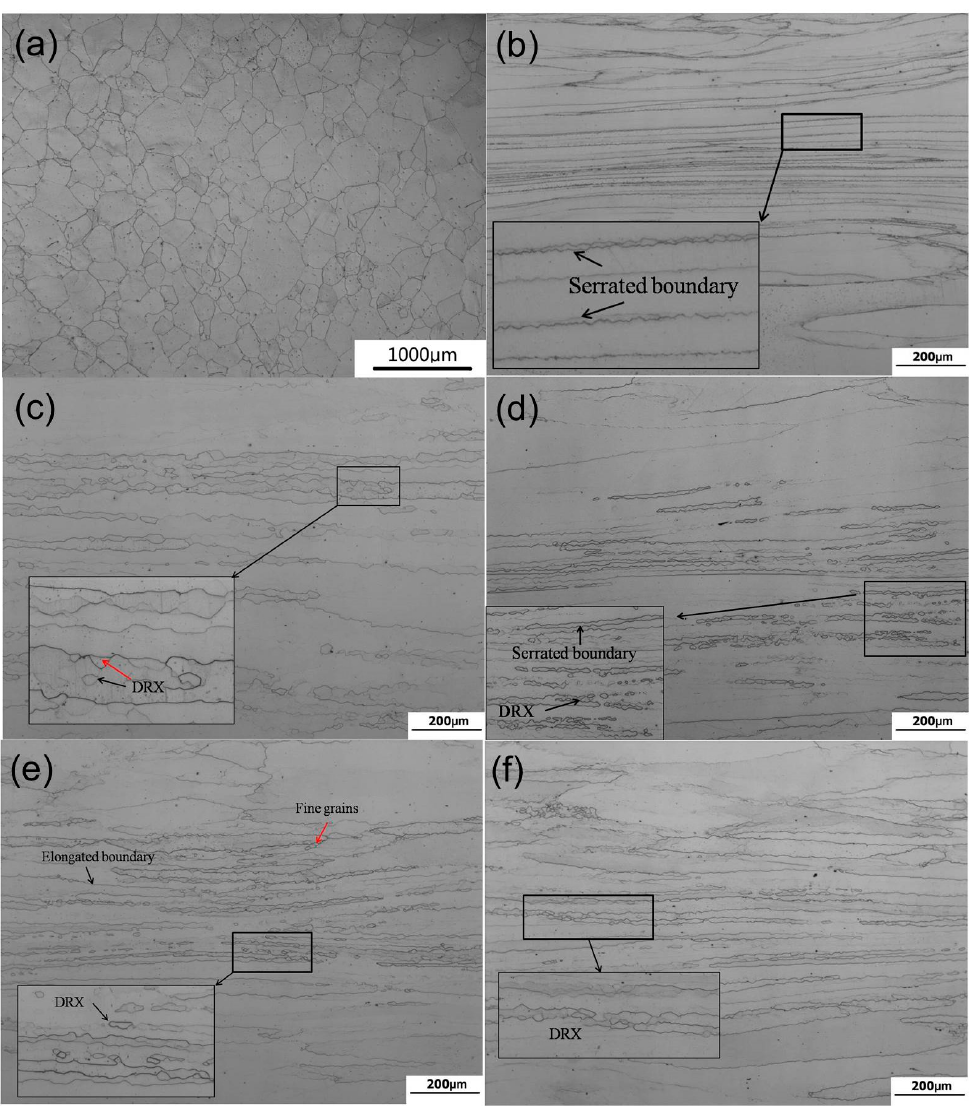
Figure 5. Microstructures of the Fe-6.5wt. %Si alloy ( a ) before and after deformation at the true strain of 1.6 under various deformation conditions: ( b ) 650 °C and 0.01 s − 1 ; ( c ) 750 °C and 0.01 s − 1 ; ( d ) 750 °C and 0.1 s − 1 ; ( e ) 850 °C and 1 s − 1 ; ( f ) 950 °C and 10 s − 1 .